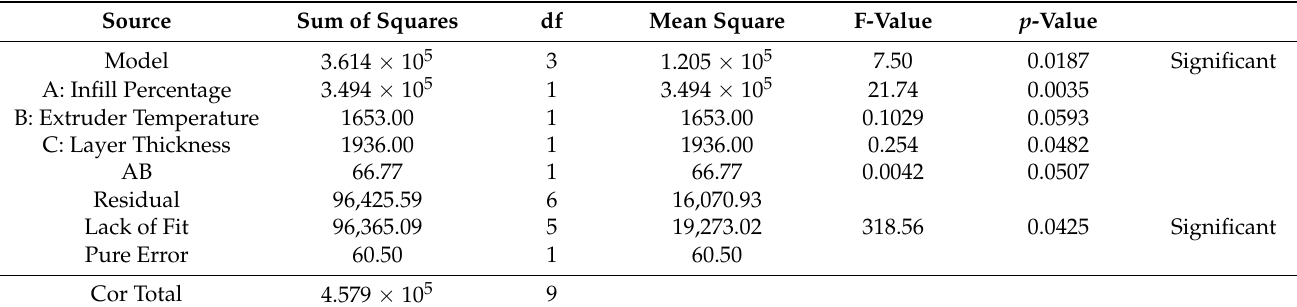
Table 5. Analysis of variance (ANOVA) for